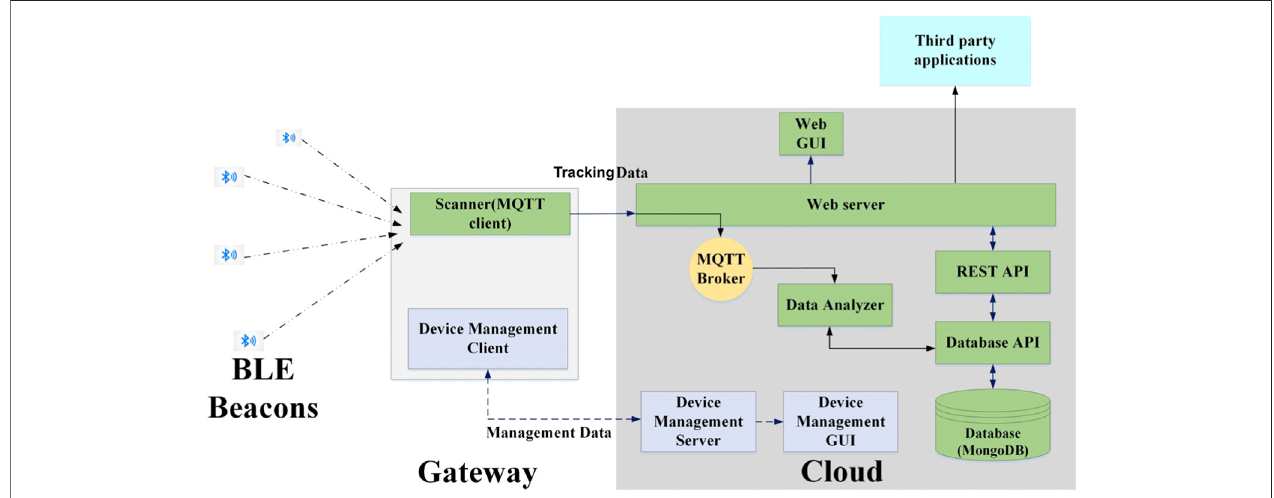
FIGURE 1 | The architecture of the tracking system applied in our case studies (adapted from Zhao et al., 2019).